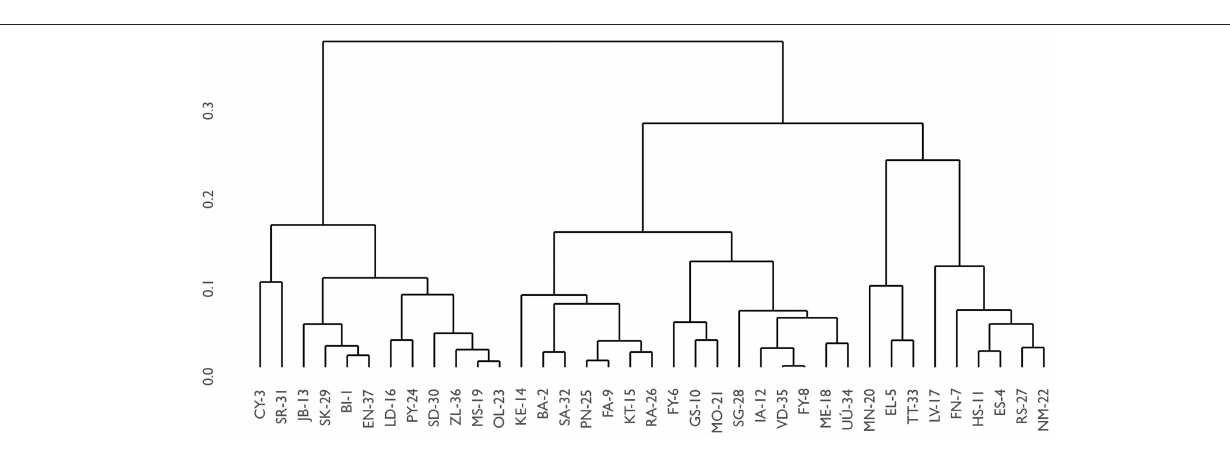
FIGURE 11 | Dendrogram of the classification of organizational cultures of the case